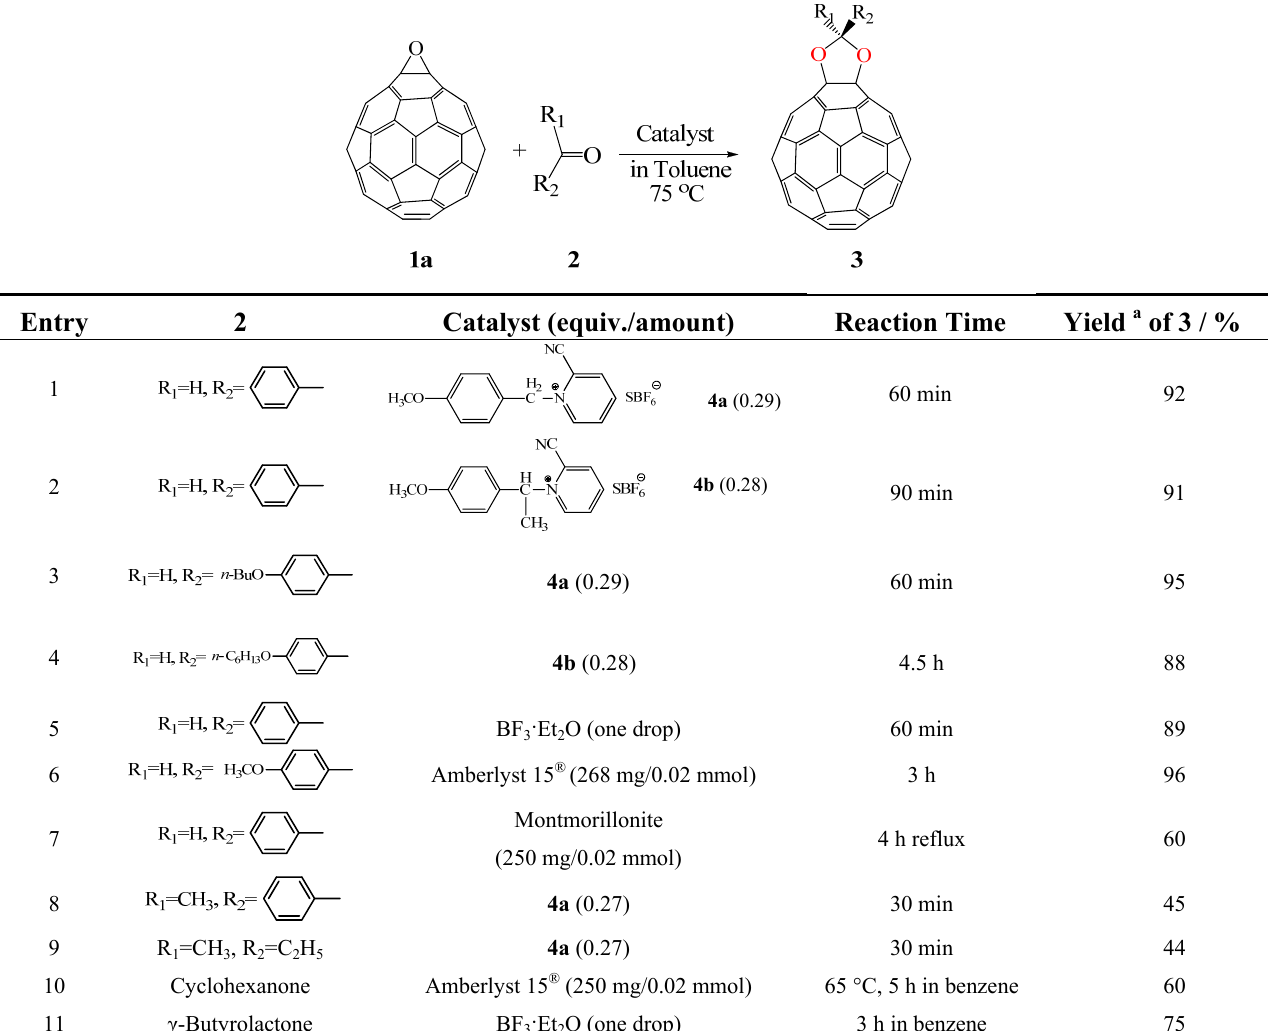
Table 2. Acetalization of fullerene epoxide 1a with carbonyl compound in the presence of an acid